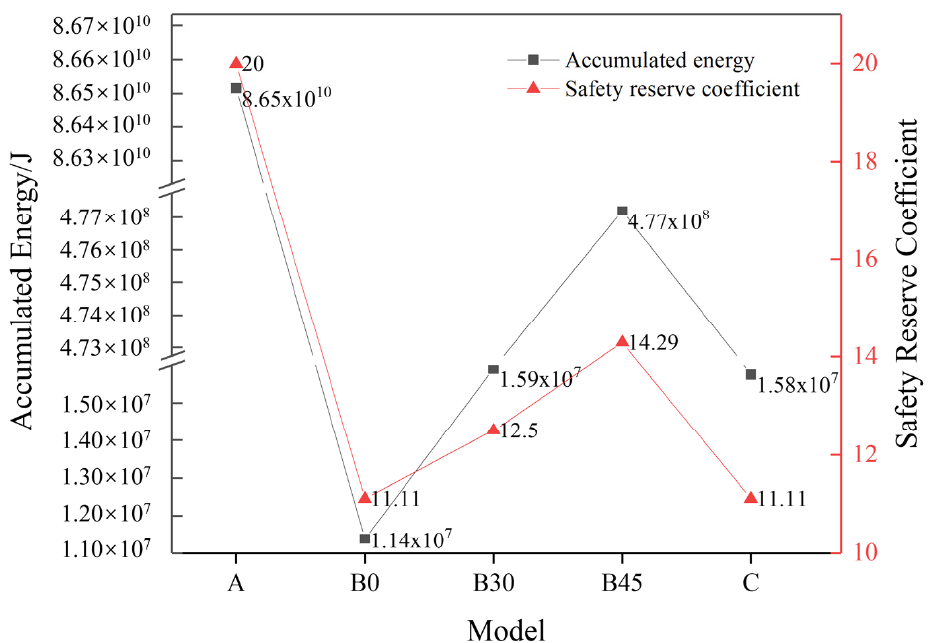
Figure 17. Relationship between the accumulated acoustic emission energy and the safety factor of the different tunnel models.